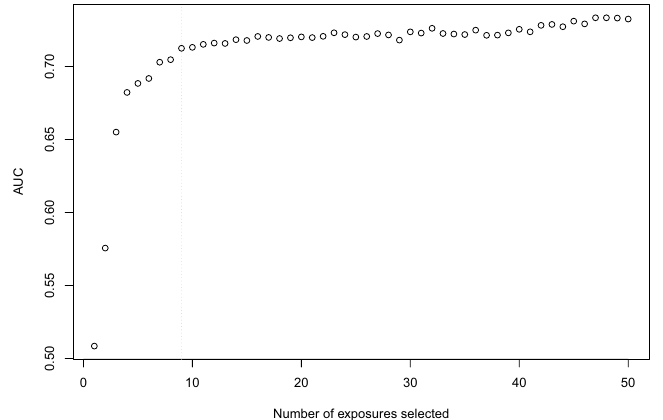
Figure 5. Exposure selection through cross-validation showing the prediction performance (Area-Under-the- Curve, AUC) (y-axis) of the model using a particular number of top-ranked exposures (x-axis). The dotted gray line represents the optimum number of exposures to select (q = 9).